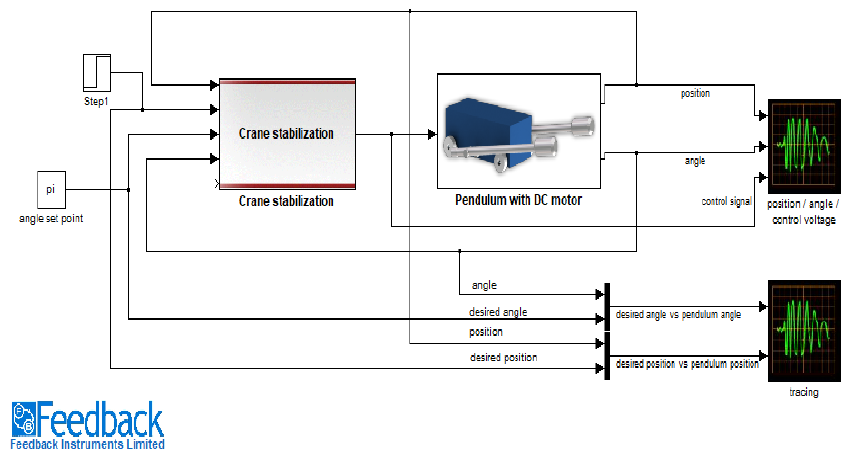
Figure 23. Design of SFMRAC for swing angle control in MATLAB Simulink.